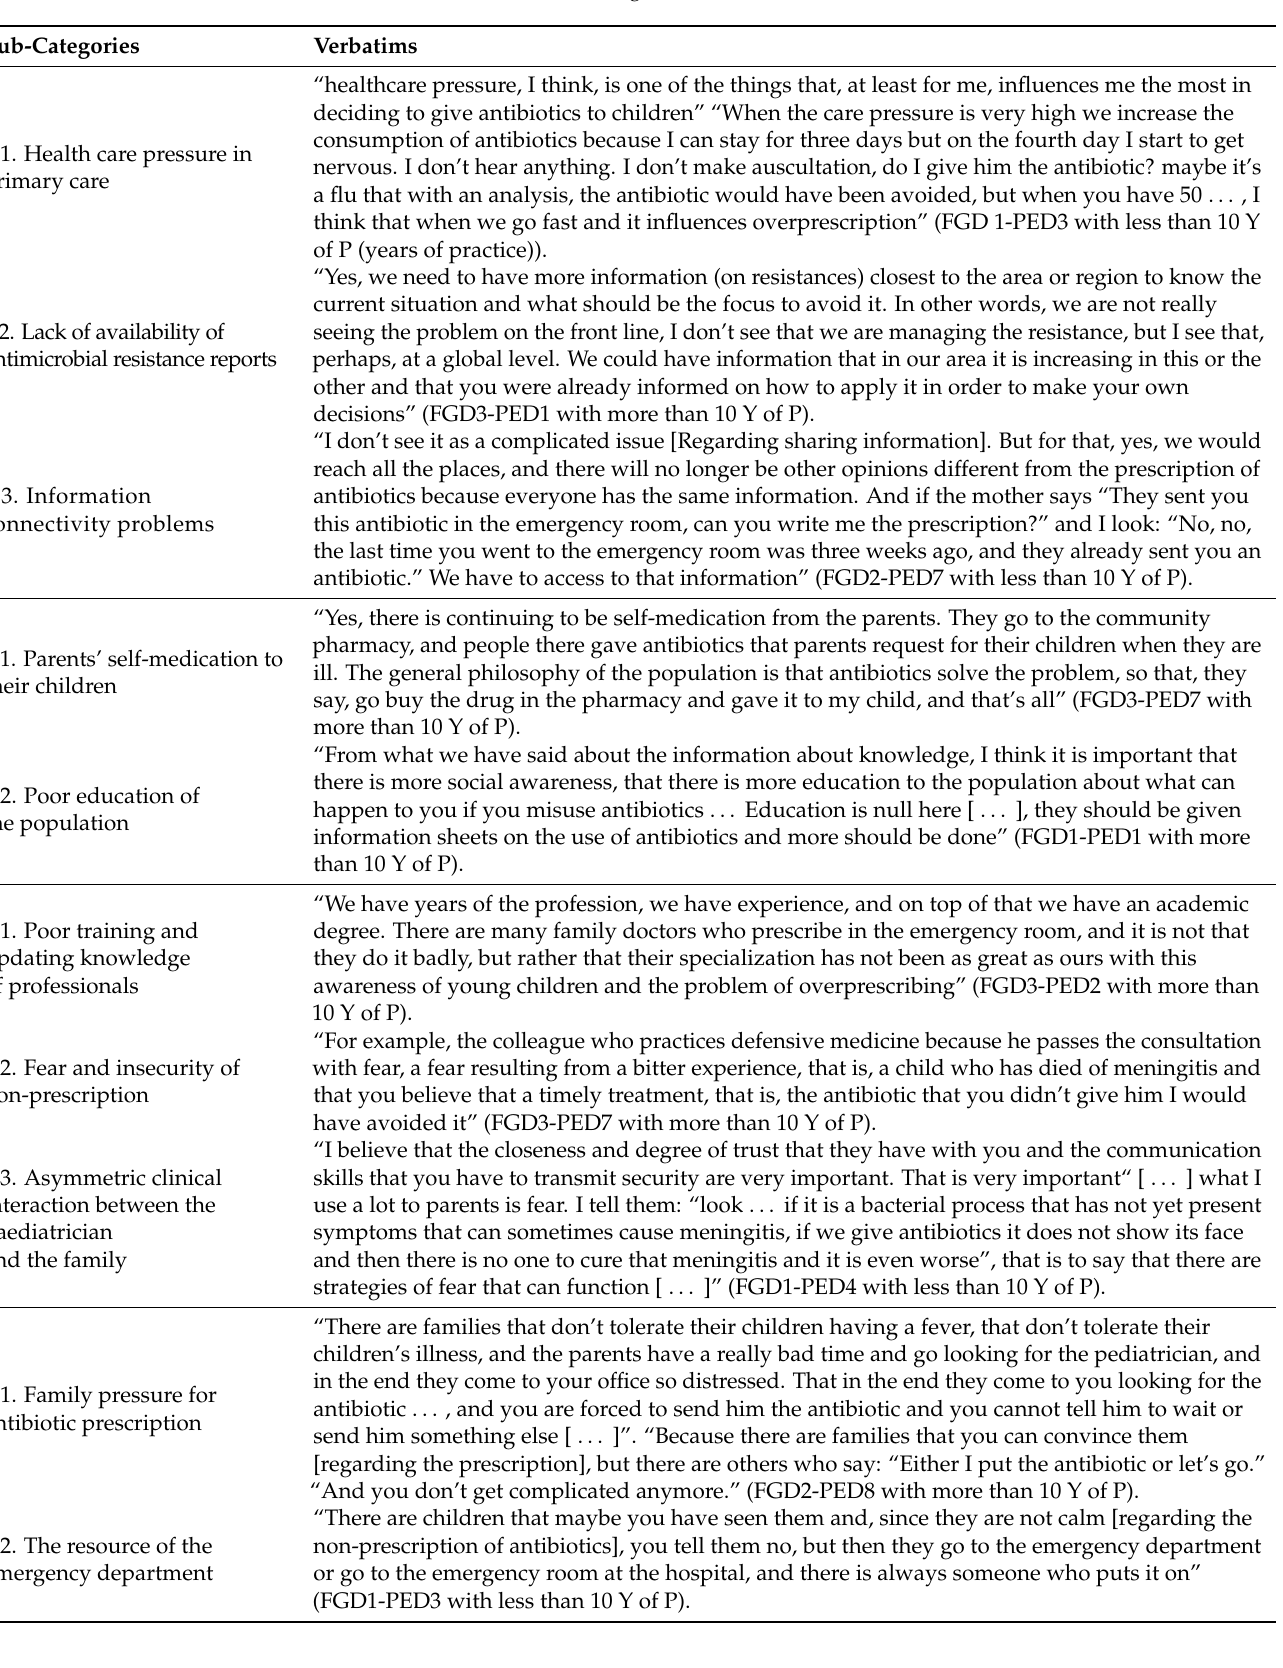
Table 3. Verbatims from